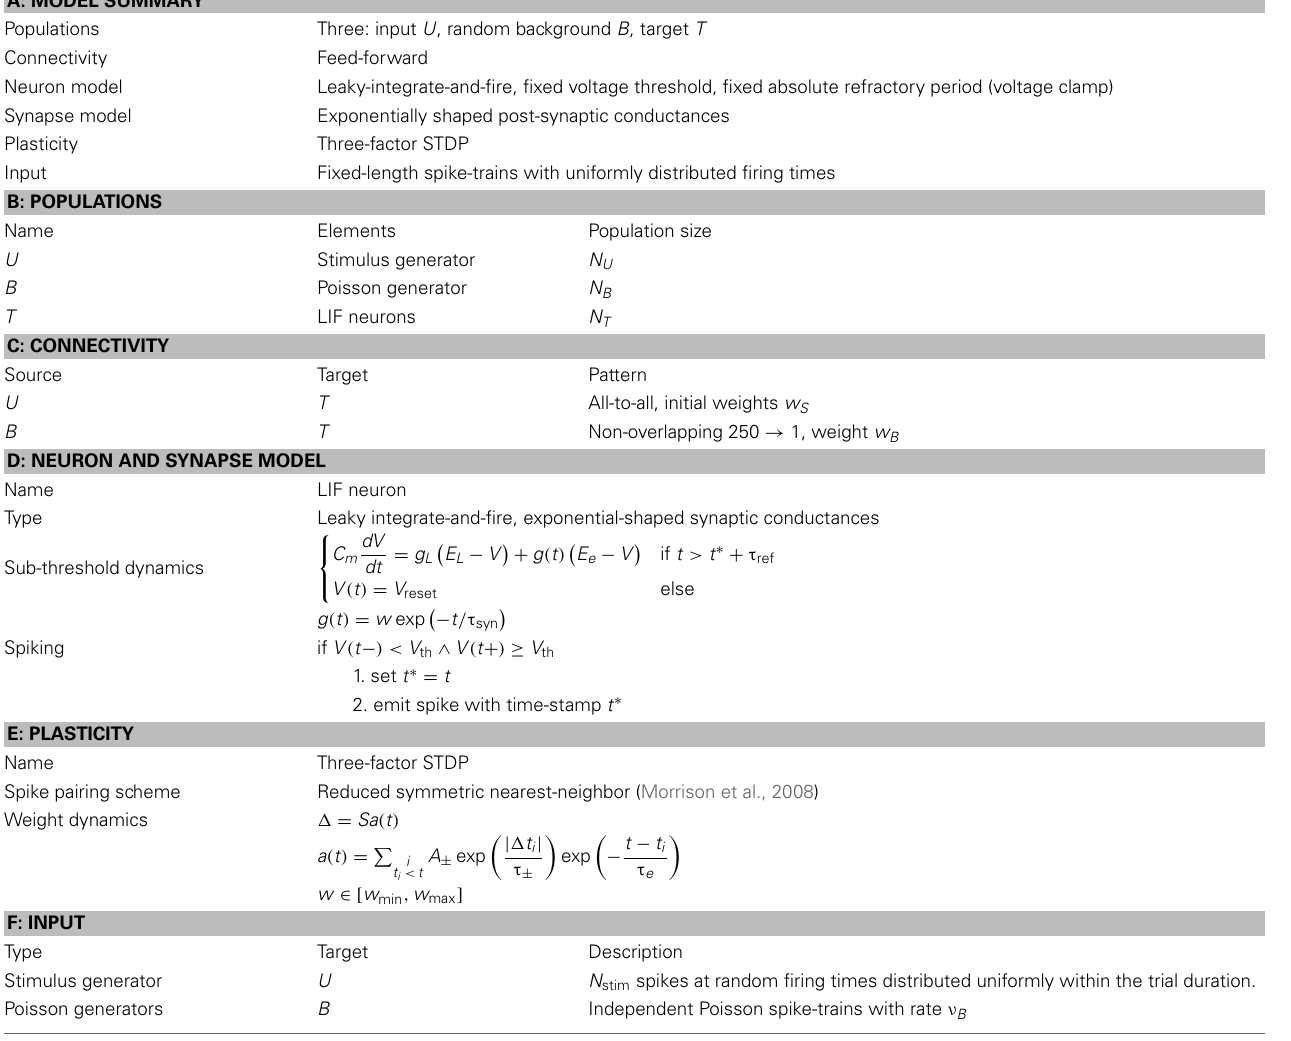
Table 1 | Description of the network model used for the learning task after Nordlie et al. (2009). A: MODEL